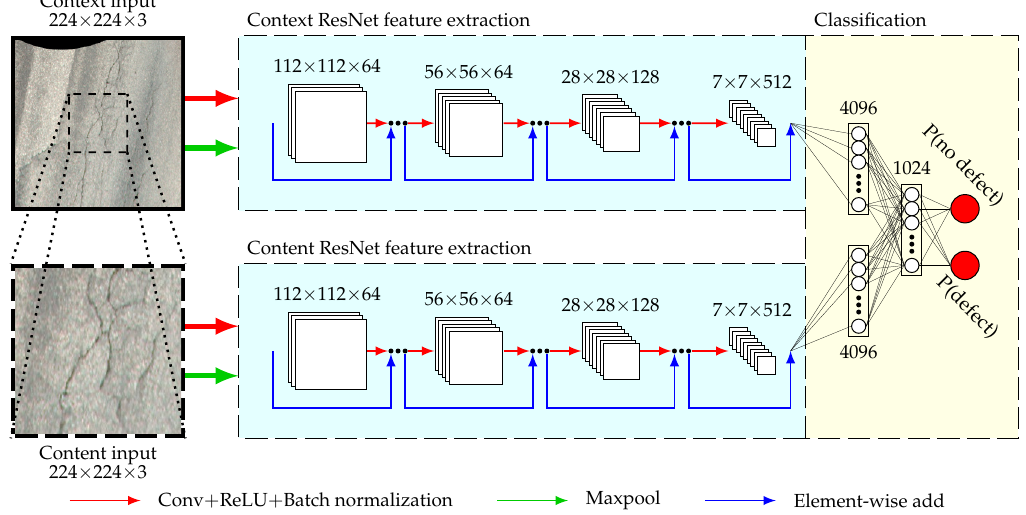
Figure 7. Architecture of the defect detection convolutional neural network (ConvNet) used in this